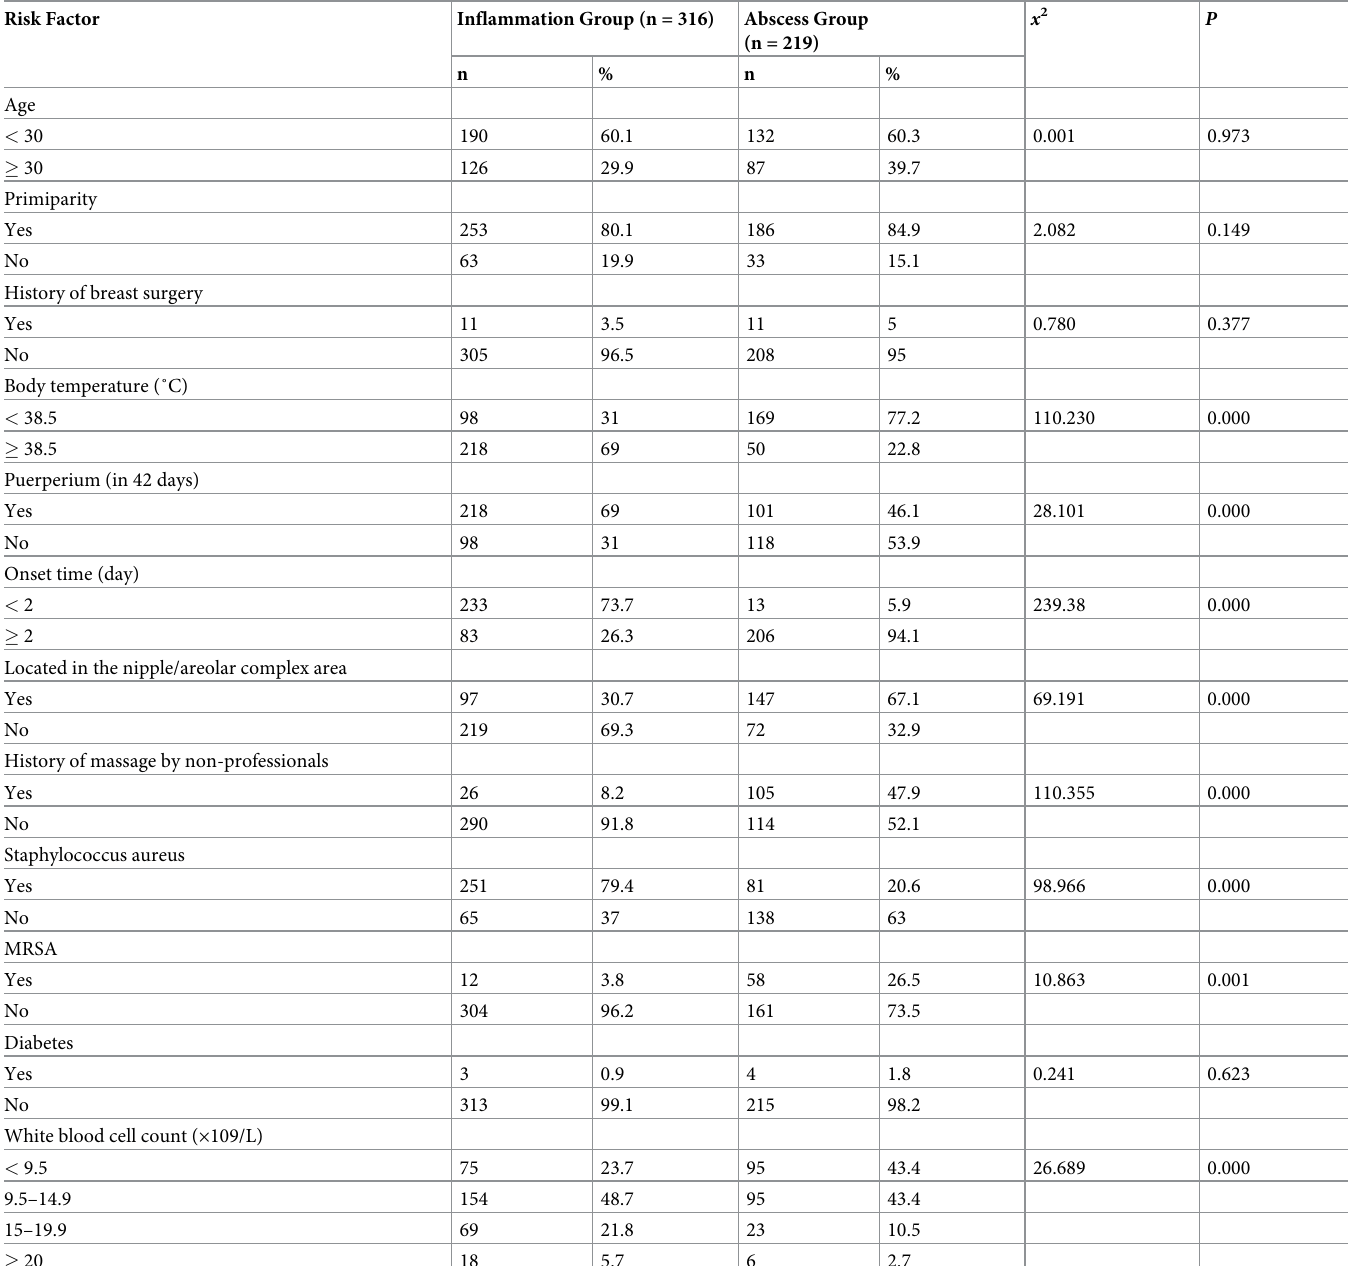
Table 3. Univariate analysis of the progression of acute mastitis to breast abscess. Risk